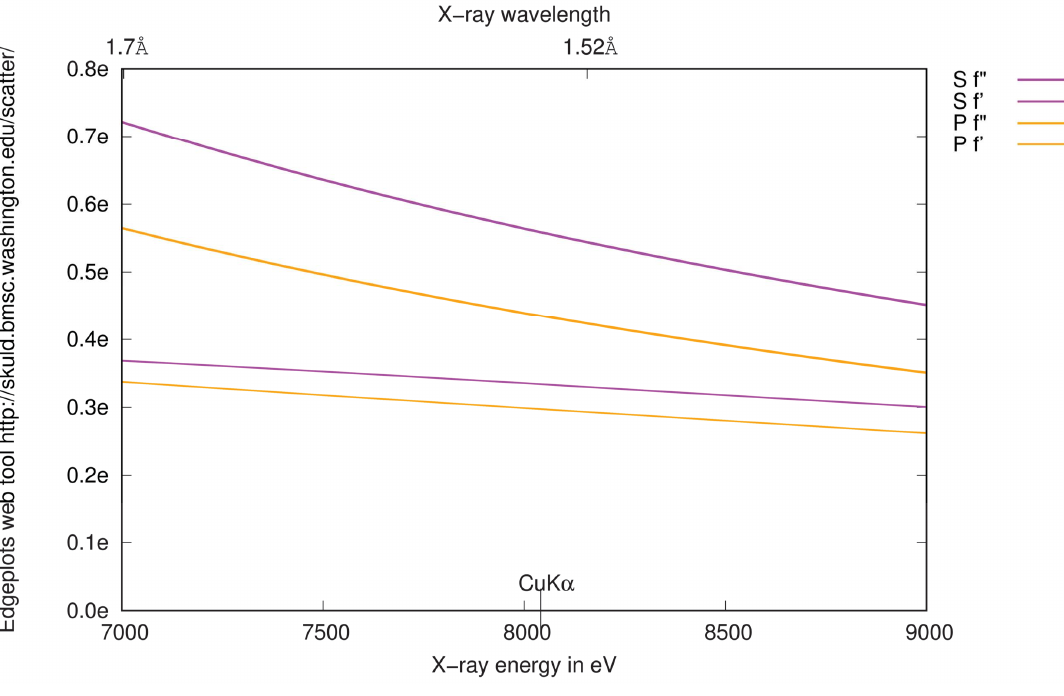
Figure 8. Plot for f (cid:48) and f (cid:48)(cid:48) for S and P atoms around the Cu K α